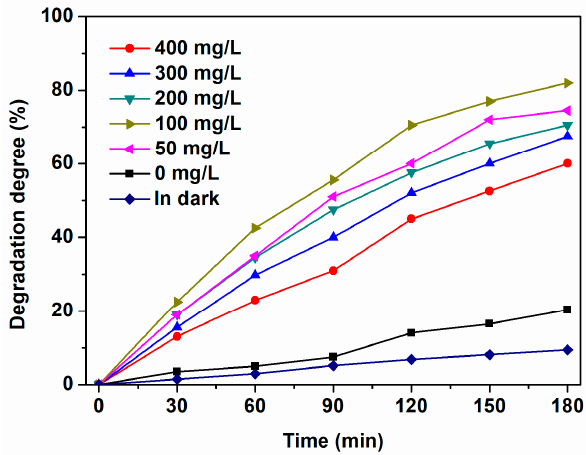
Figure 1. Effects of different TiO 2 dosages on the photodegradation rate of HBCD (the initial concentration of HBCD is 25 mg/L, and KPS dosage is 0 mg/L).